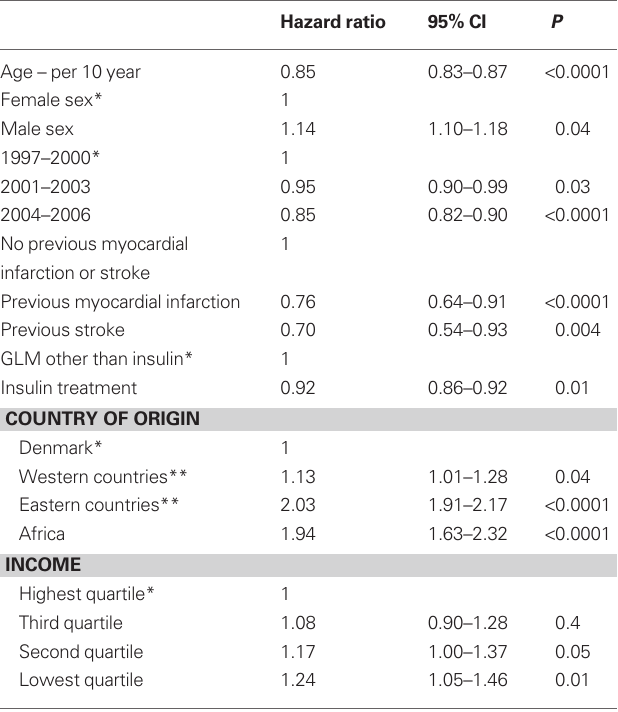
Table 3 | Cox proportional-hazard analysis of covariates influencing discontinuation of statin treatment for 90 days or more in subjects receiving glucose-lowering